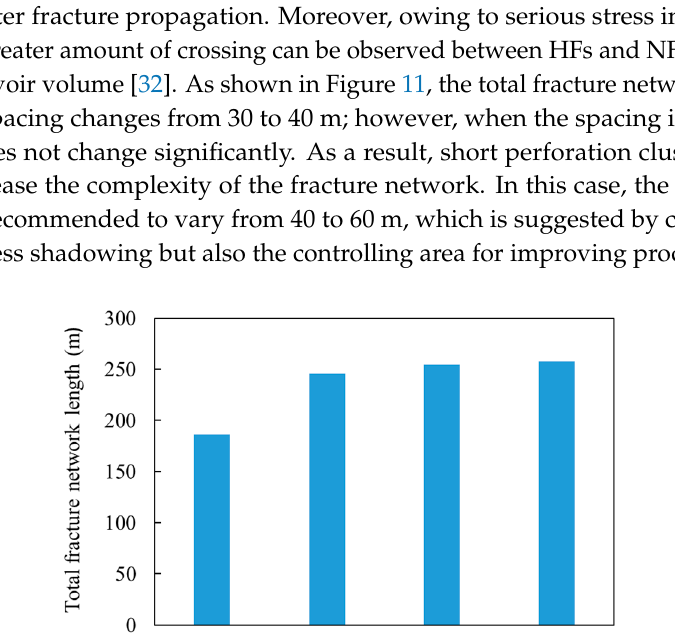
Figure 11. Fracture network lengths at different cluster spacing distances.